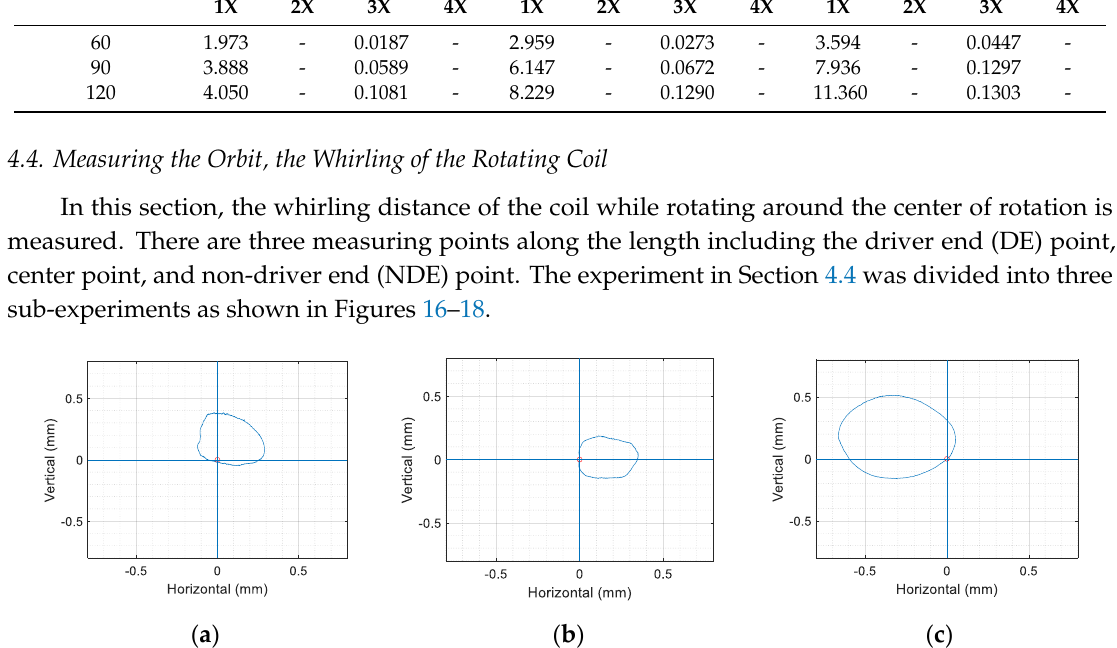
Figure 17. The comparison of the movement characters of the rotating coil at 90 RPM: ( a ) shaft orbit at the DE side; ( b ) shaft orbit at the center; ( c ) shaft orbit at the NDE side.